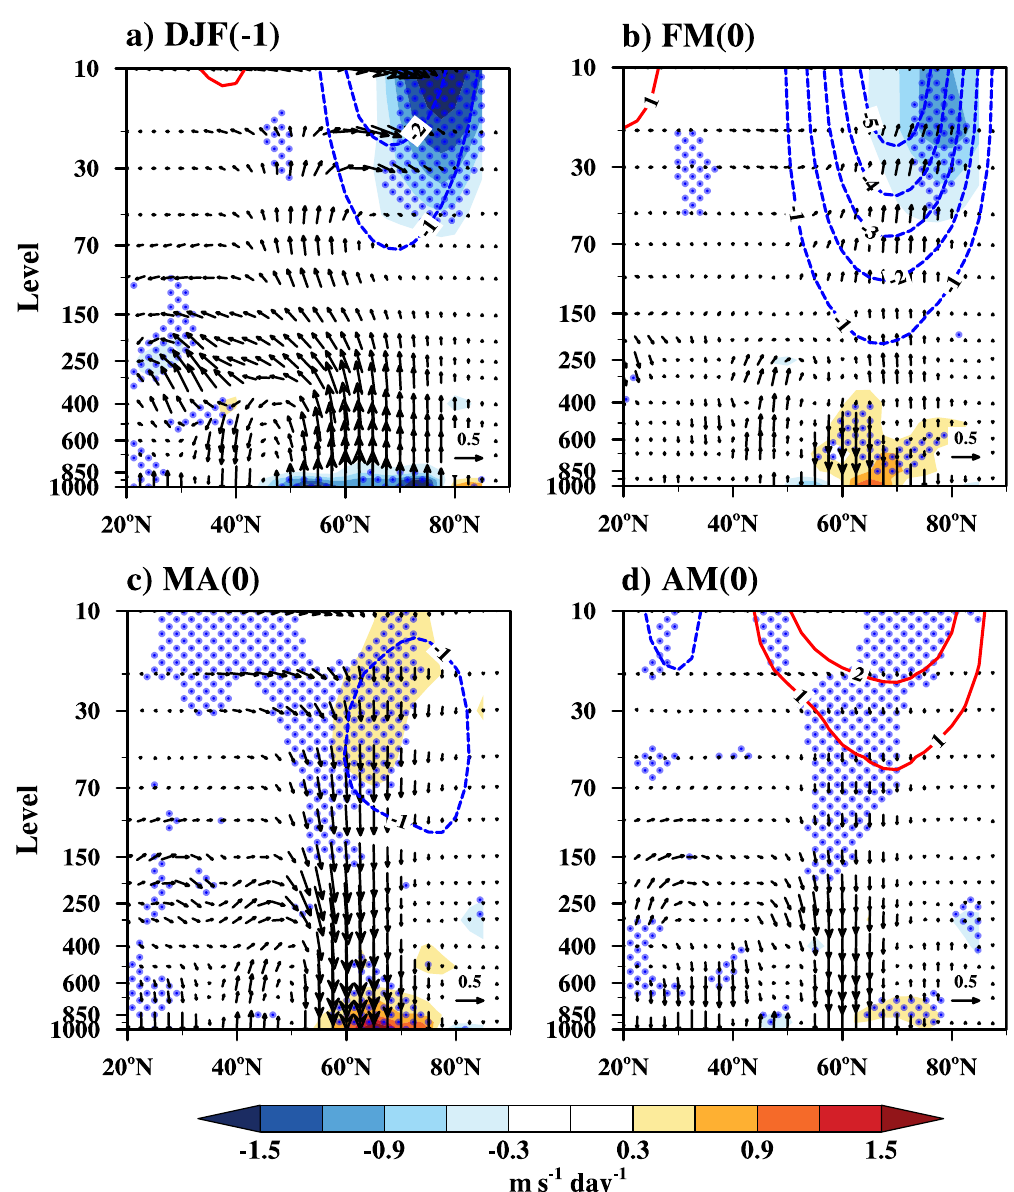
Fig. 4 Winter BK sea ice-related stratosphere – troposphere interactions. Zonal mean EP fl ux (10 8 m 2 s − 2 , vector), EP fl ux divergence (m s − 1 day − 1 , shading), and zonally mean zonal wind (m s − 1 , contour) anomalies in a DJF( − 1), b FM(0), c MA(0), and d AM(0) regressed onto the negative winter BK ffiffiffiffiffiffiffiffiffiffiffiffiffiffiffiffi p sea ice index. Vectors are scaled by 1000 = P , and vertical EP fl ux is multiplied by 125 for display. Contour interval is 1 m s − 1 . Blue and red contours indicate the negative and positive zonal wind anomalies. Dotted areas denote EP fl ux divergence anomalies signi fi cant at the 90% con fi dence